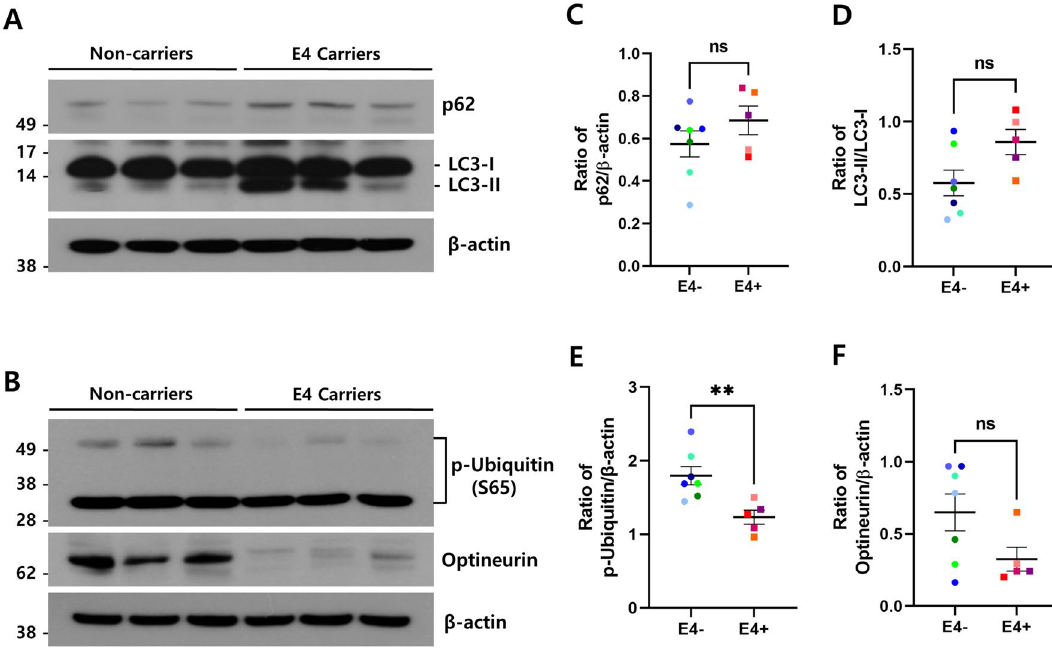
Figure 3. Autophagy/mitophagy components were quantitatively altered in the brains of ApoE4 carriers. The protein levels of p62, LC3, p-ubiquitin (Ser65), optineurin, and β-actin in ApoE4 non-carriers (n = 7, E4-) vs. carriers (n = 5, E4 +) were analyzed by immunoblotting using corresponding antibodies, respectively. Representative western blot analysis of p62 and LC3 ( A ), p-ubiquitin (Ser65), and optineurin ( B ). β-actin was used as a loading control. Full blots are provided in Supplementary Fig. S4. Relative ratio of p62 ( C ), LC3-II ( D ) p-ubiquitin (Ser65) ( E ), and optineurin ( F ) against the protein levels indicated on the y-axis, respectively. Data shown are mean ± SEM. (** p < 0.01). ns not